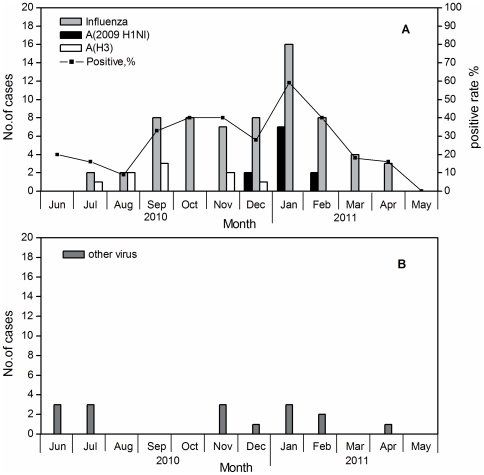
Monthly distribution of test-positive virus in the PKU People' hospital from June 2010 to May 2011.
Figure 1A shows the number of respiratory specimens testing positive for influenza, by influenza type and positive rates of respiratory virus. Panel B shows the smaller number of other viruses. The rate of positive cases of the virus gradually increased from August to October, slowly decreased in November, and then increased again in January 2011. The peak of the positive rate occurred in January 2011 and influenza was the predominant virus between August 2010 and March 2011. Particularly in August, September and October 2010, and March 2011, all infections were caused by FLU only( Figure 1B). The number of positive cases of influenza virus increased rapidly in September and peaked in January 2011, following which it then decreased to normal levels in March 2011. Influenza A(H3) was the predominant viral etiological factor and was only observed from July to December 2010, and again, in January 2011, Influenza A(H3) were replaced by 2009 H1N1. 2009 H1N1 peaked in January 2011. Most influenza viruses were in fact influenza A, with influenza B virus only observed in April 2011. In June, multiple infections predominated. Each identified ILI was caused by a single virus except in June, July and November 2010 and January and February 2011: two FLU-A in August, eight FLU-A in September and in October each, eight FLU-A and one HRCV229E/NL63 in December, four FLU-A in March 2011, one FLU-A, two FLU-B and one ADV in April 2011, No virus was detected in May 2011. On the other hand, two of the three identified ILI samples in June were mixed infections, HRSV and HRV. Other double infections included: One HRCV/FLU-A in July, one FLU-A/HRV in November, two HRSV-A and FLU-A and one HRSV-A and HRV and FLU-A in January 2011, one HRSV-A and HRV and FLU-A in February 2011.